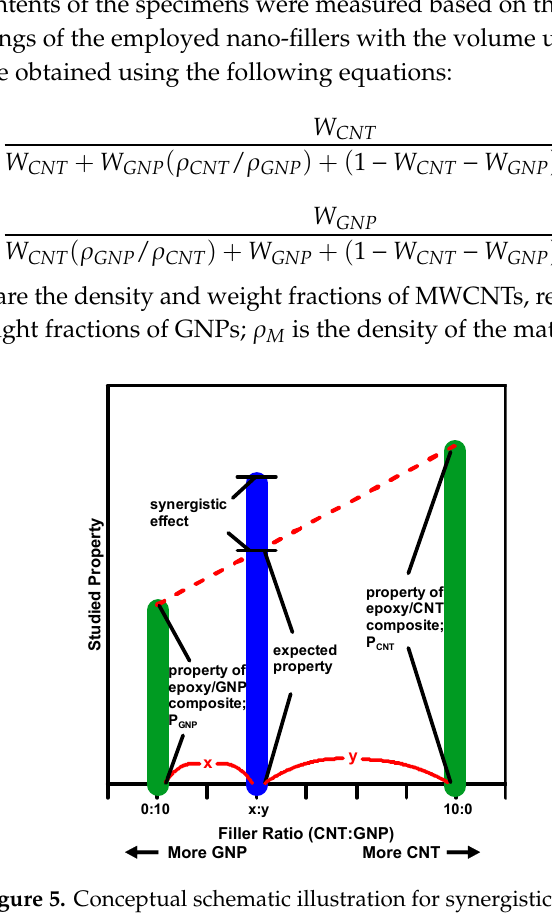
Figure 5. Conceptual schematic illustration for synergistic index. Table 3. Parameters used in the modified Halpin-Tsai